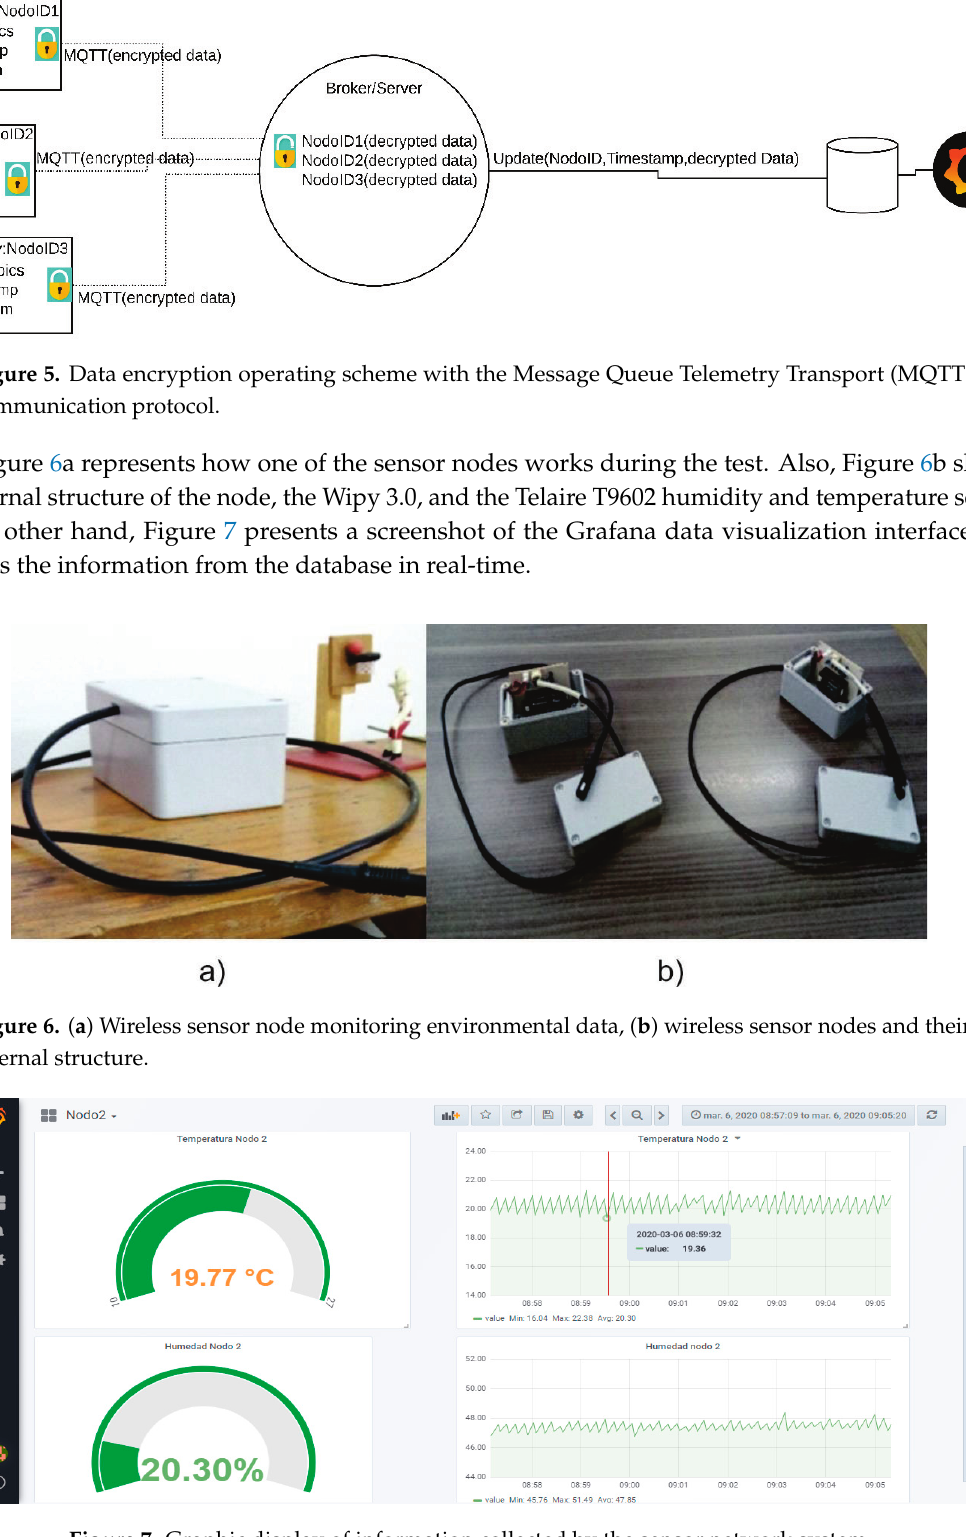
Figure 7. Graphic display of information collected by the sensor network system.